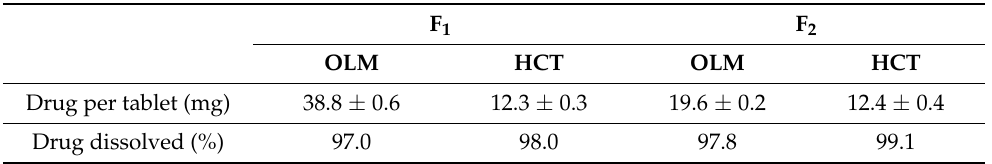
Table 2. Drug content and percentage of labelled drug dissolved in the dissolution test for F 1 and F 2 formulations.